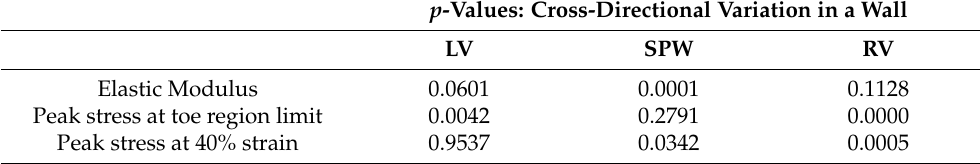
Table 1. Statistical significance test results for axis-to-axis variations in biaxial mechanical parameters. All statistically significant results in bold